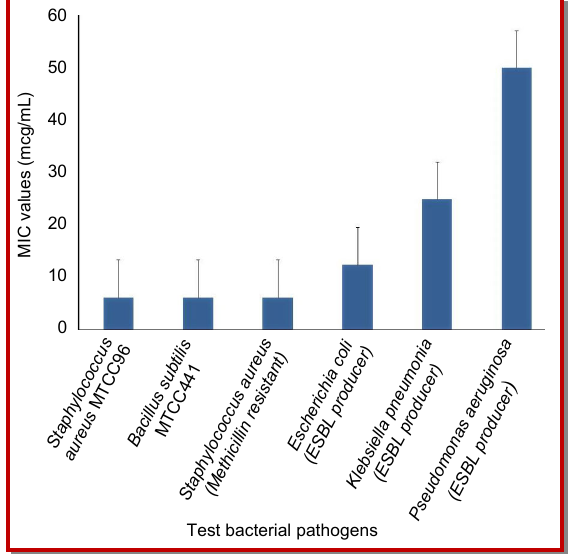
Test bacterial pathogens Figure 1: Anti-microbial activity of quercetin against standard and MDR microbial pathogens